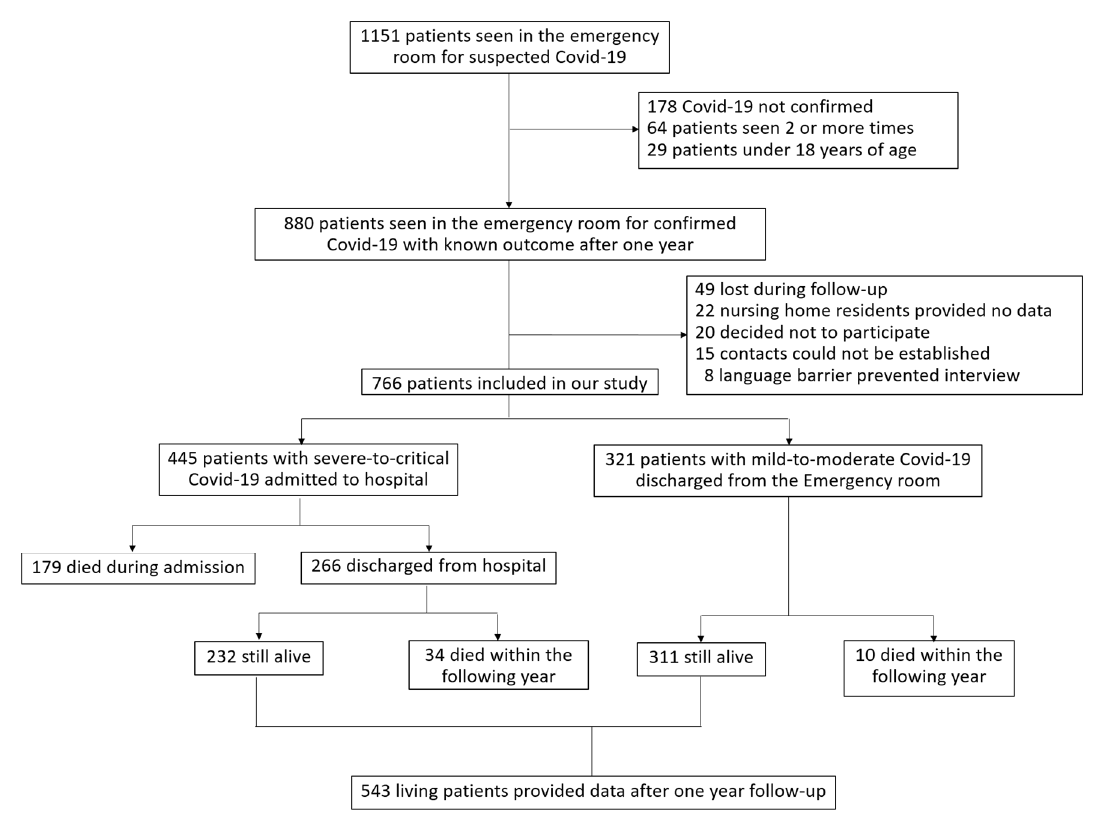
Figure 1. Flow chart of patients who attended Tomelloso General Hospital during the first wave of the COVID-19 pandemic, and who were admitted to hospital or discharged from the emergency room. After one year, patients were evaluated for the long-term consequences of the disease. Table 1. Demographic and baseline comorbidities of COVID-19 patients attending our hospital during the first wave of the pandemic (1 March to 1 June 2020), and for whom we had information on clinical outcomes after a year. Characteristics of patients who were discharged from the emergency room and those who were admitted to hospital are